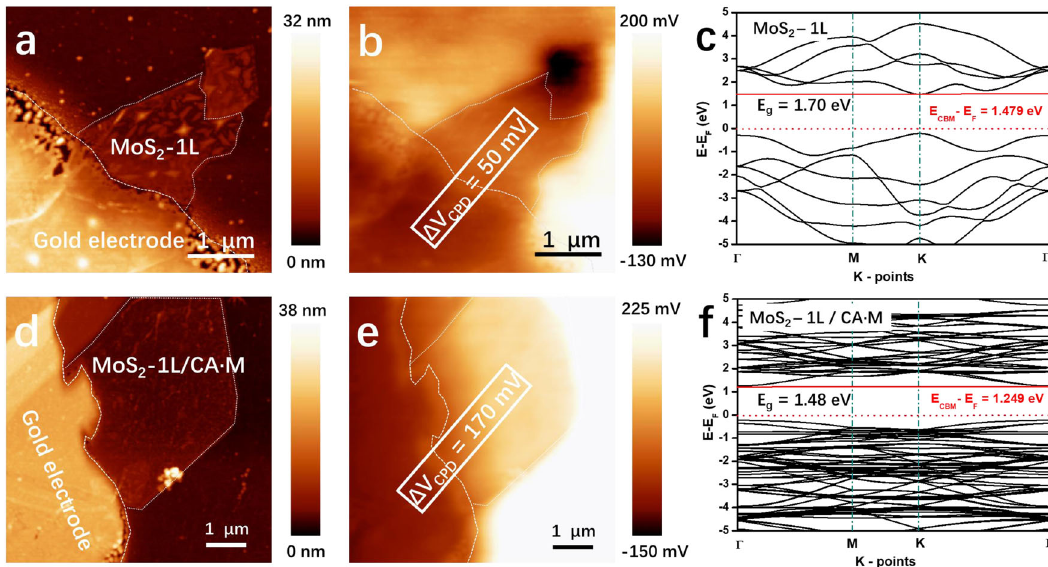
Fig. 4 Morphology and energetics of coated and uncoated MoS 2 monolayers. The area of monolayer MoS 2 fl ake (1L-MoS 2 ) is circled by white dotted lines. a Atomic force microscope (AFM) height image and b Kelvin probe force microscope (KPFM) image of a monolayer MoS 2 fl ake. c Calculated electronic band structure of monolayer MoS 2 . d AFM image and e KPFM image of a CA·M doped MoS 2 monolayer fl ake. f The band structure of monolayer MoS 2 /CA·M heterostructure. Contact potential difference ( Δ V CPD ) is the contact potential difference between the E F of the fl ake and that of the Au electrode ( E F,MoS2 − E F,Au )/ e . The energy level of conduction band minimum ( E CBM ) is marked with red solid lines, and the Fermi level ( E F ) is marked with the red dashed lines. E g is the energy gap between conduction band minimum and valence band